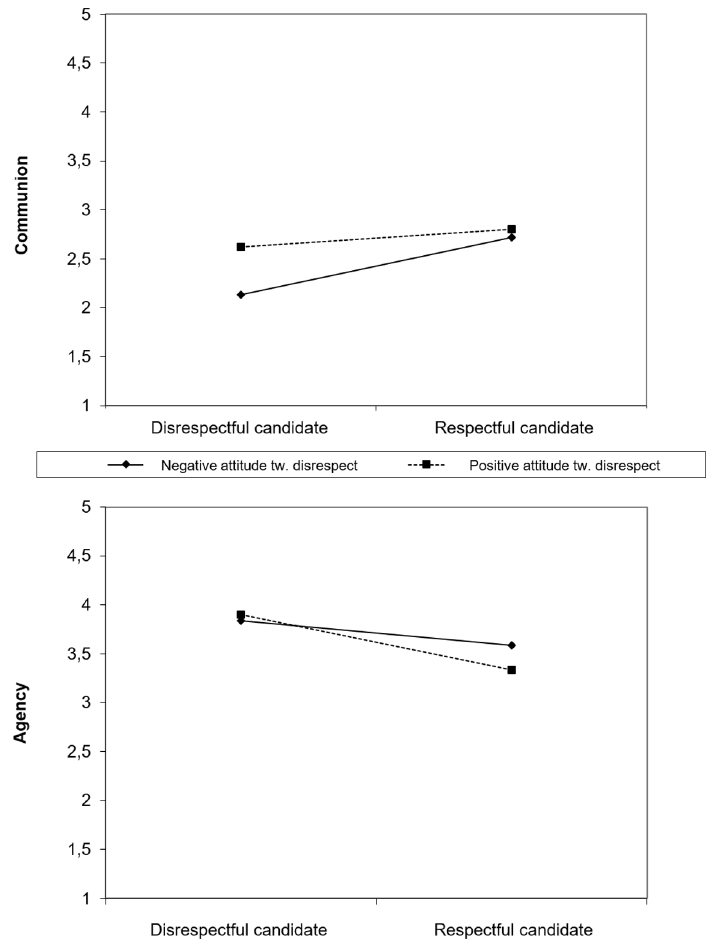
Figure 2. Simple slopes for the interaction effect of disrespectful vs. respectful candidate behavior and participants’ attitude towards disrespect on their communion and agency judgments of the candidate in Study 1 ( N = 229).